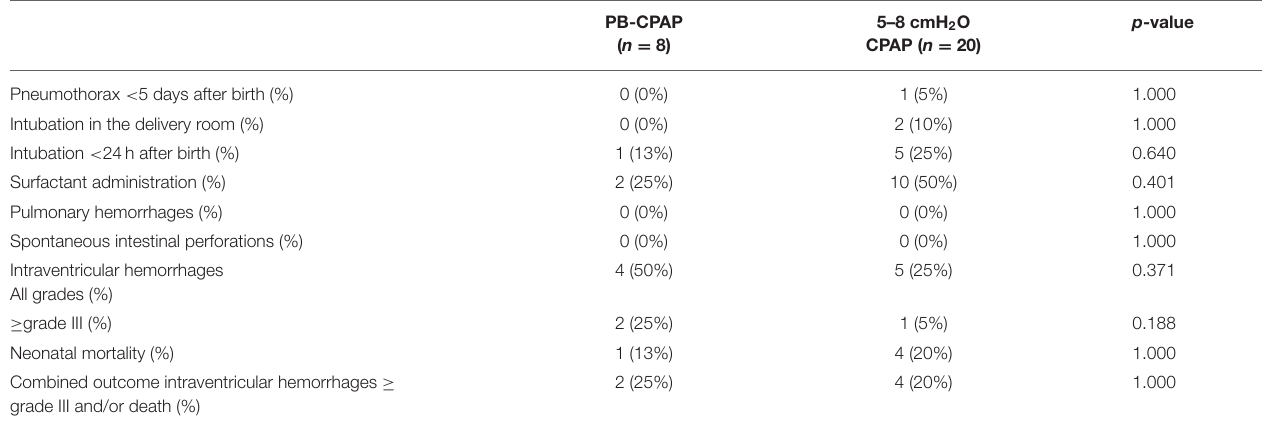
TABLE 3 | Short-term clinical